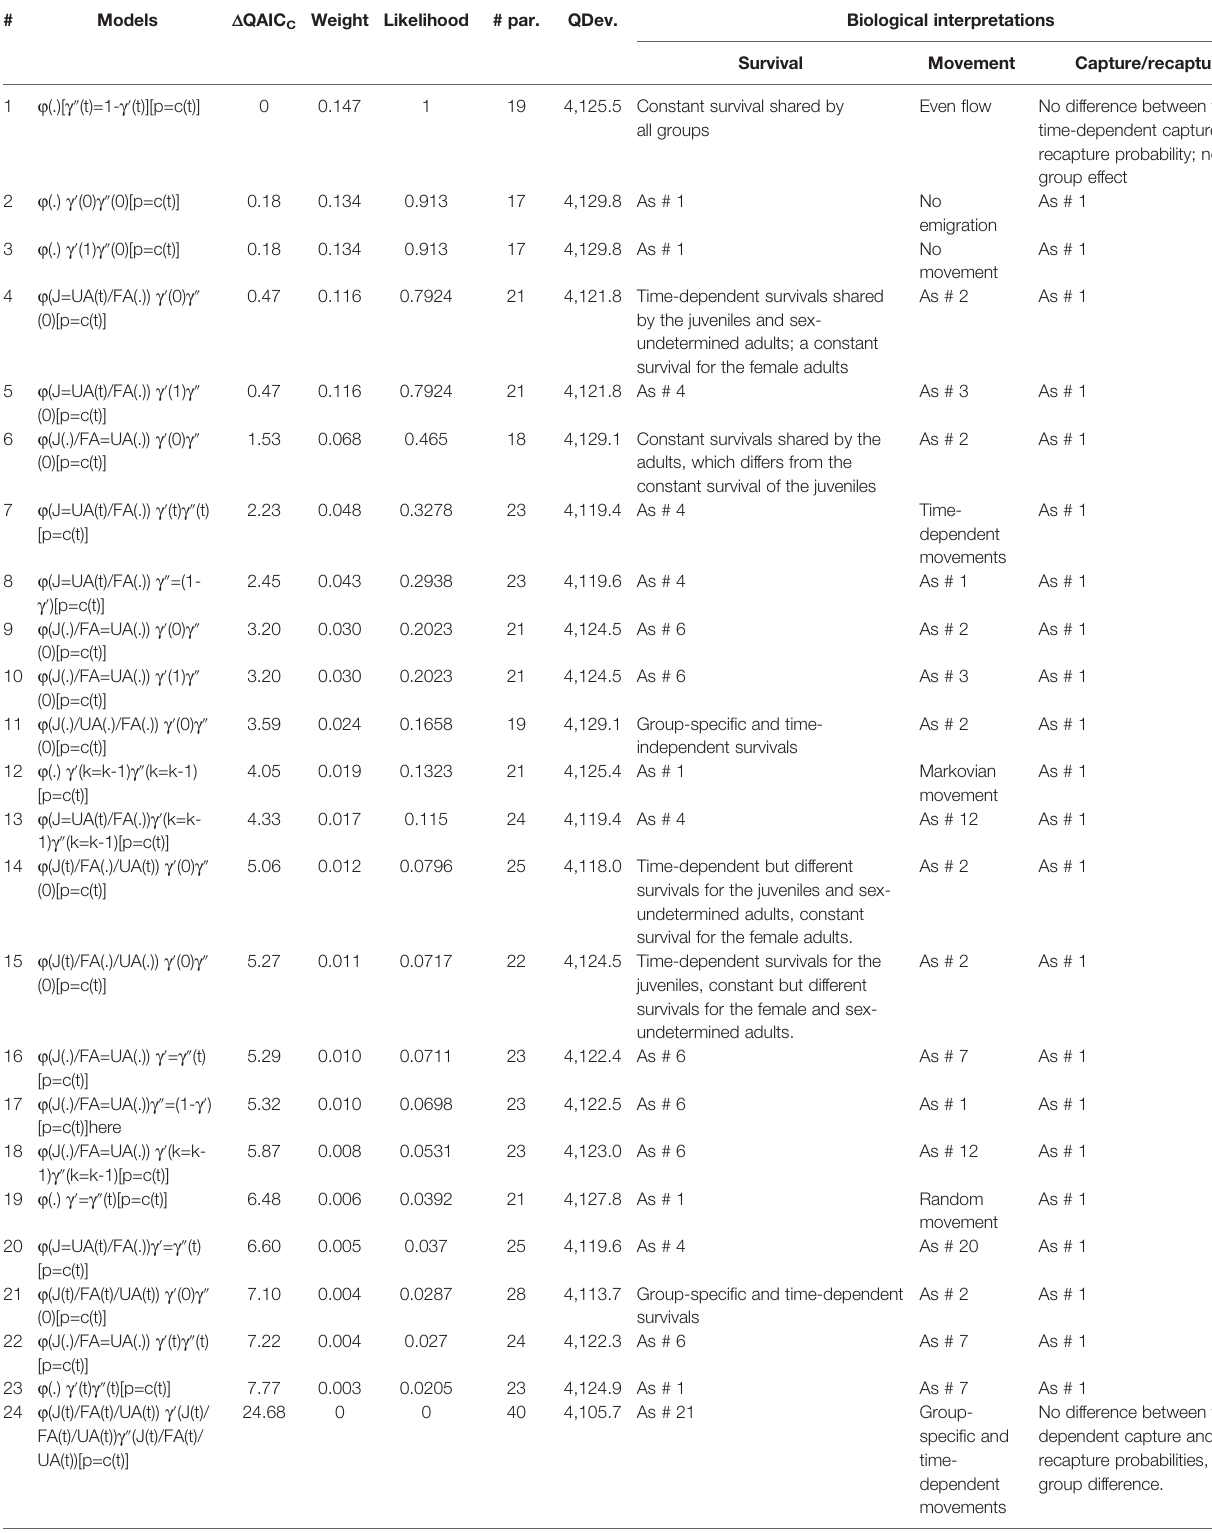
TABLE 4 | Model selection of 27 robust design models in estimating the survival ( j ), movement ( g ), and capture/recapture probabilities (p/c) of the Dafeng River estuary (DRE) Indo-Paci fi c humpback dolphins. # Models D QAIC C Weight Likelihood # par.